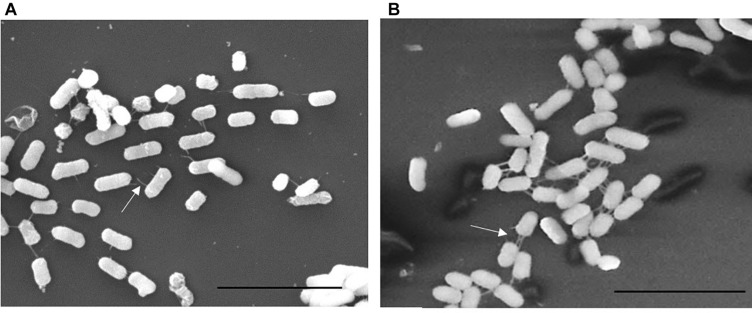
Scanning Electron Microscopy (SEM) of C227-11 (A) and C227-11aar
(B). White arrows indicate fimbria. Scale bar is 5 μm.